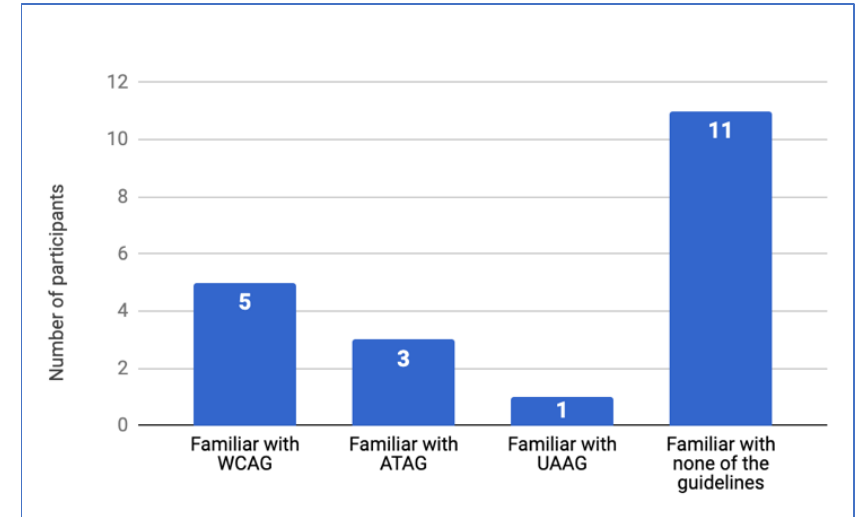
Figure 6. Familiarity with accessibility guidelines.